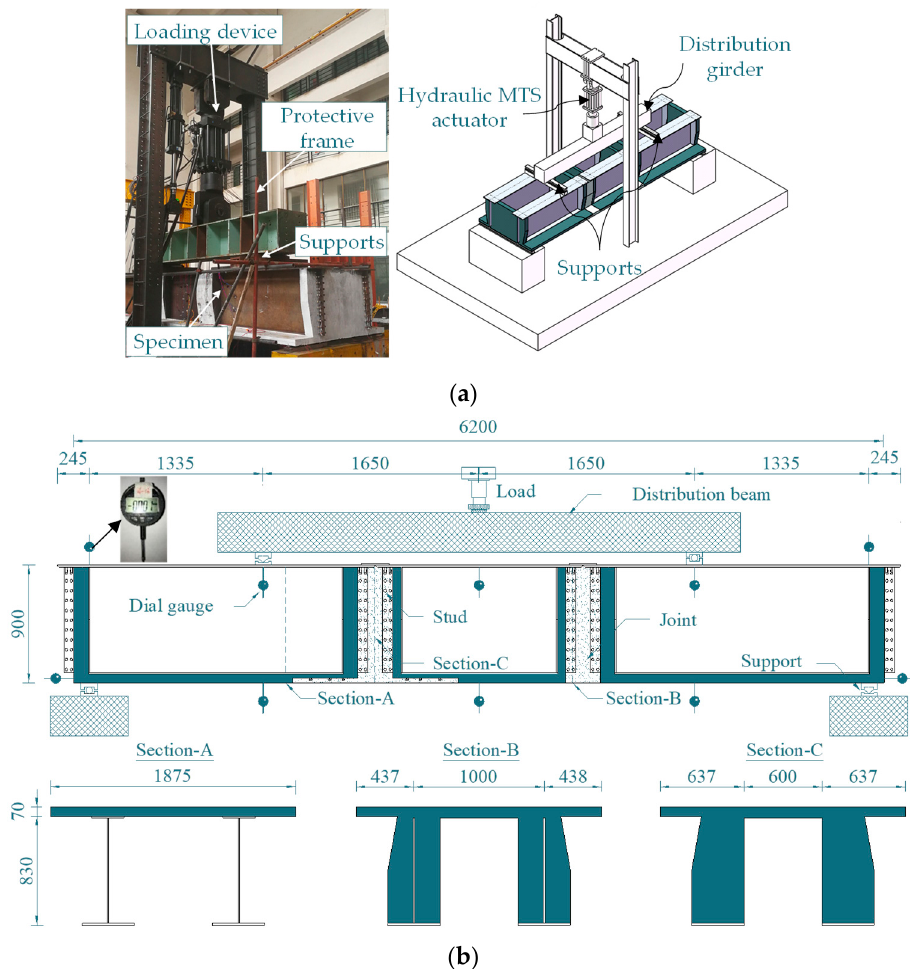
Figure 5. Loading and measuring device: ( a ) Loading method; ( b ) measuring device layout .